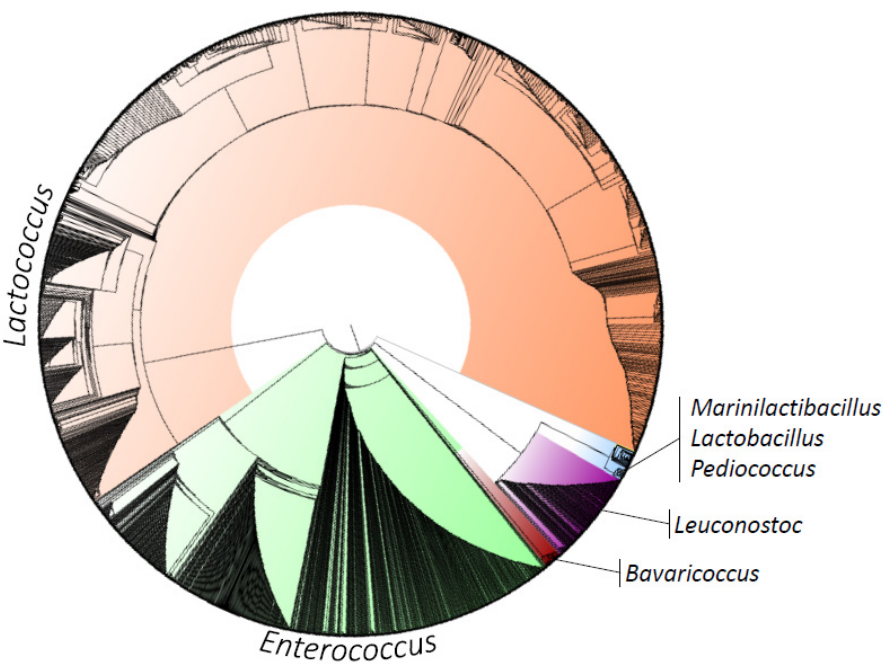
Figure 4. Phylogenetic relationships between the sequences obtained in the metagenomic sequencing detected by the phylogenetic marker located in the V3–V4 region of the 16S rRNA gene. The sequences of the isolates were compared using the neighbor joining method and visualized graphically in FigTree software.